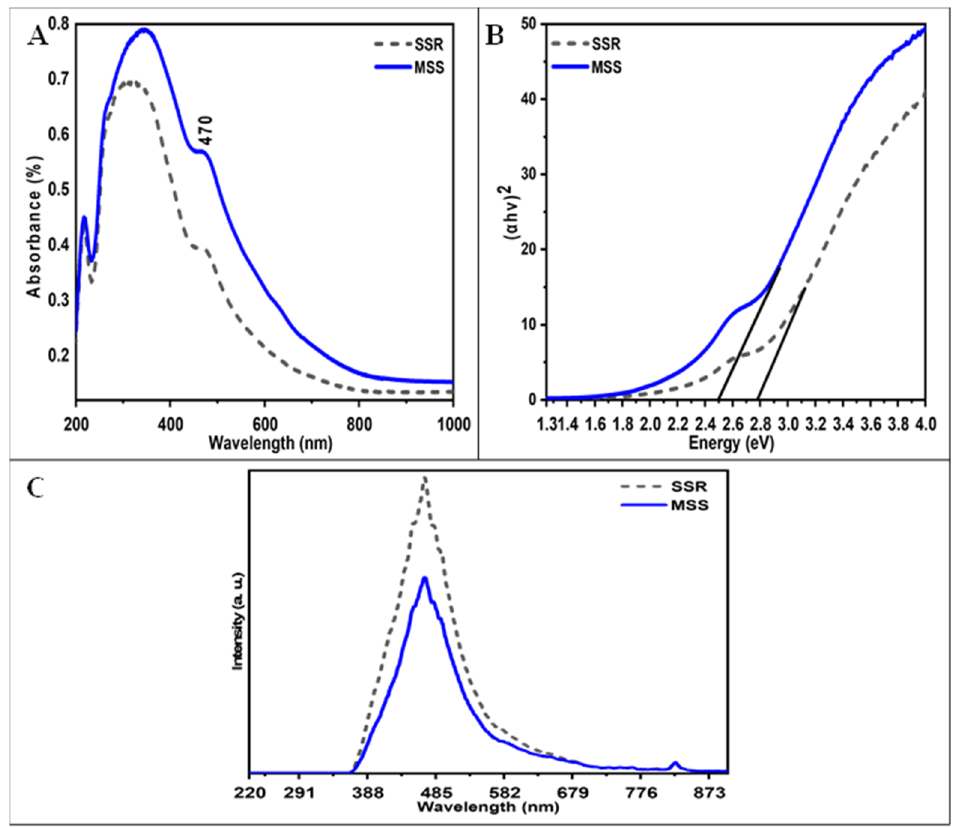
Fig. 8. UV-visible absorbance [A], the Tauc plot [B] and photoluminescence emission [C] curves of zinc aluminate samples synthesized by both SSR and